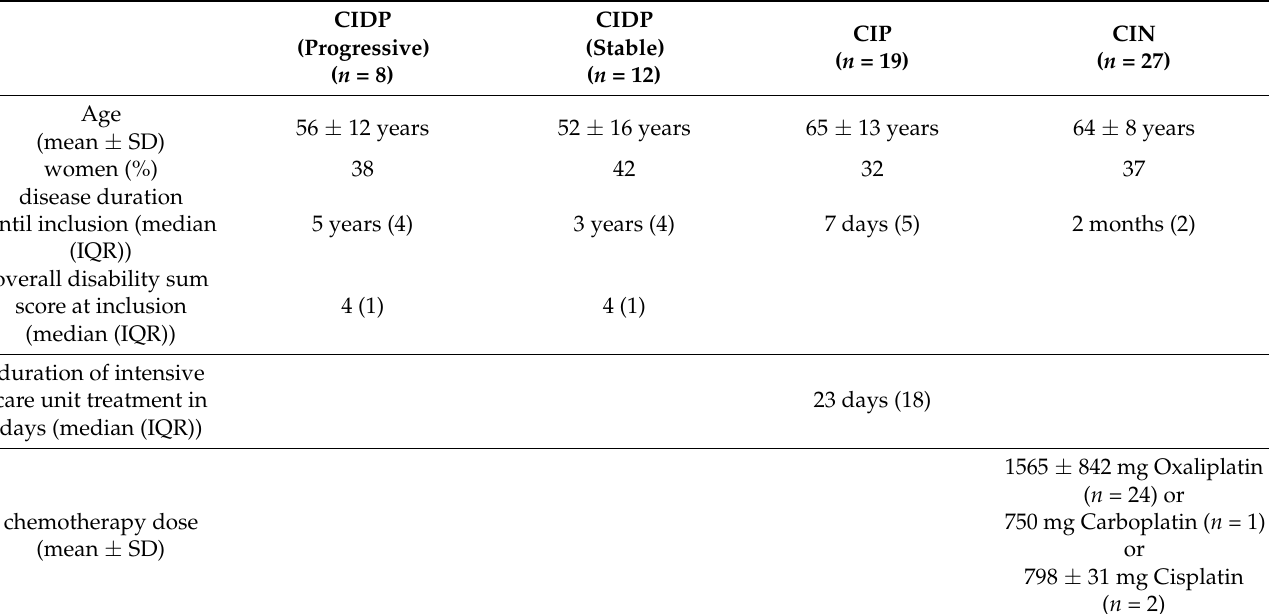
Table 1. Baseline characteristics of all